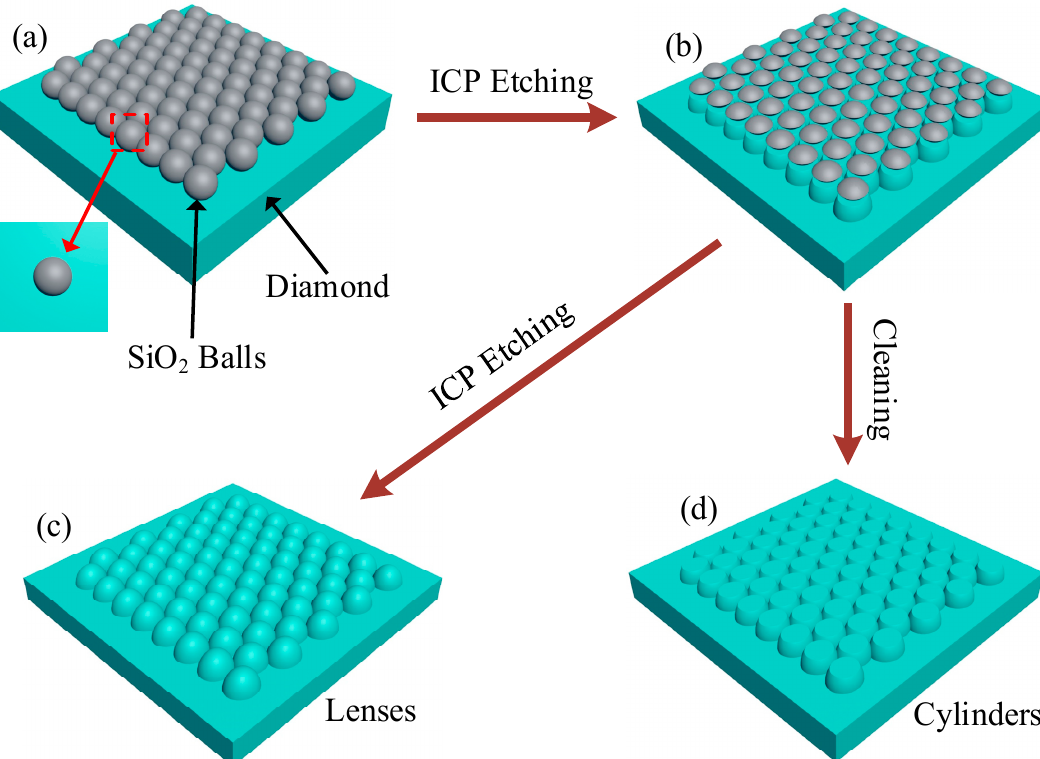
Figure 1. Fabrication process flow of submicron lenses and cylinders. ( a ) Coating a layer of SiO 2 balls on diamond surface. ( b ) ICP Etching SiO 2 and diamond simultaneously. ( c ) Lenses were obtained by etched SiO 2 completely. ( d ) Cylinders were obtained by removing SiO 2 .